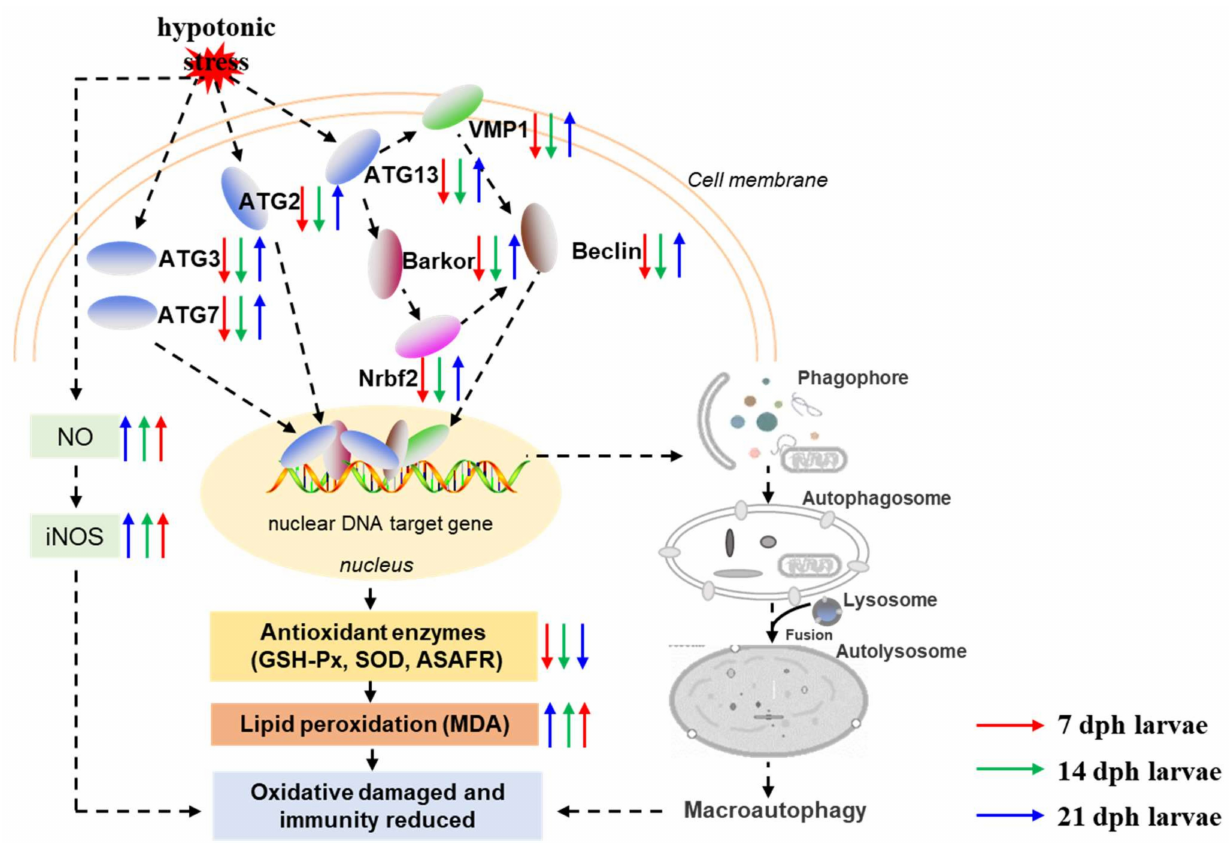
Figure 7. Schematic diagram depicting the effects and possible mechanisms of hypotonic stress on antioxidant, immune capacity and autophagy related genes expression. Notes: The red arrow is representative of 7 dph larvae, green arrow is representative of 14 dph larvae, and blue arrow is representative of 21 dph larvae under hypotonic stress compare with normal salinity group; The upward arrow is representative of gene expression activation and the downward arrow is inhibition of gene